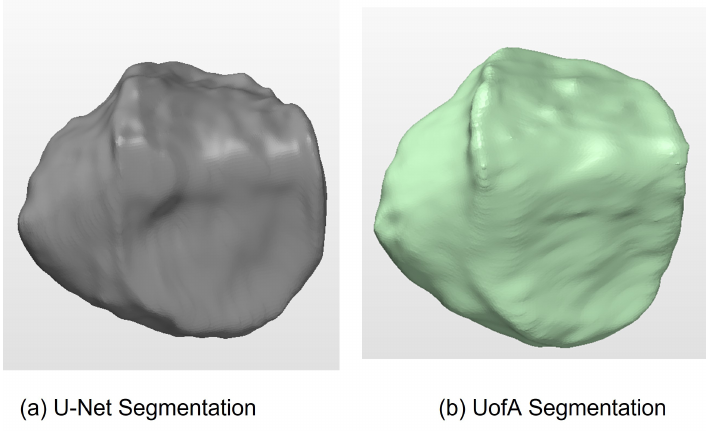
Figure 13. Patella 3D mesh model produced by ( a ) U-Net and ( b ) the UofA ground